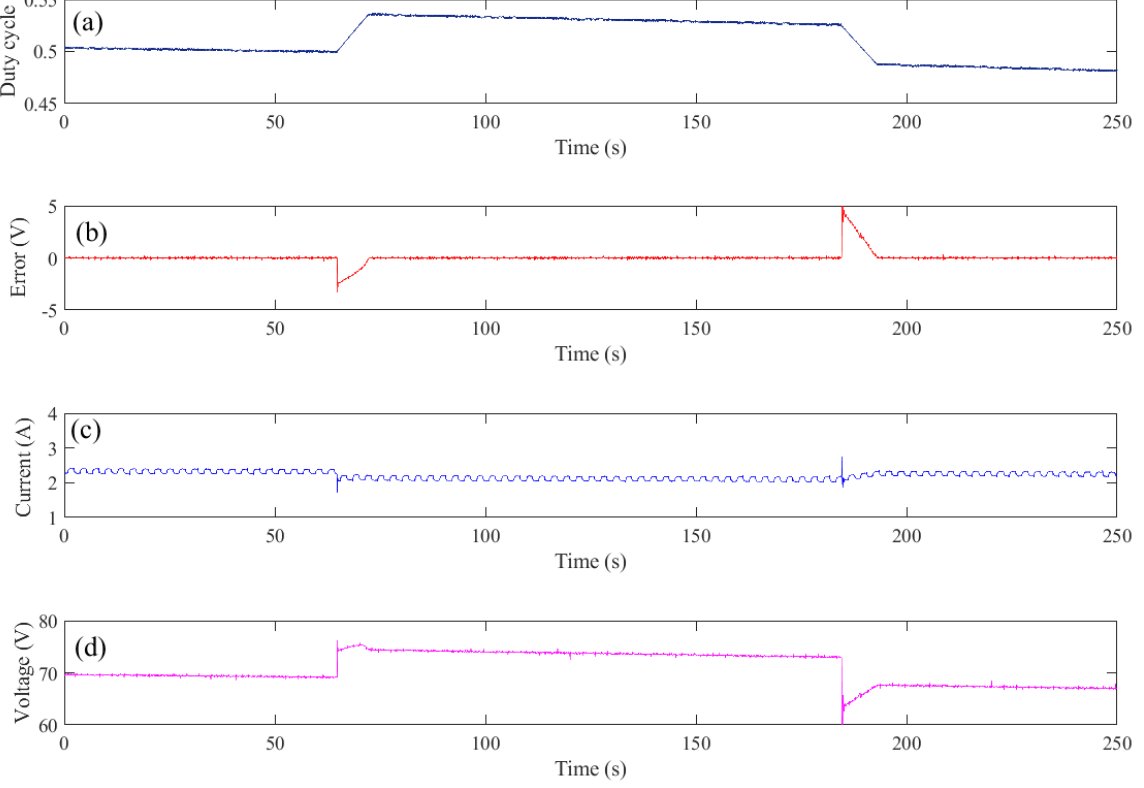
Figure 21. MPPT based on RNN and FLC: ( a ) Duty cycle; ( b ) Error; ( c ) Boost converter output current ( I out ); ( d ) Boost converter output voltage ( V out